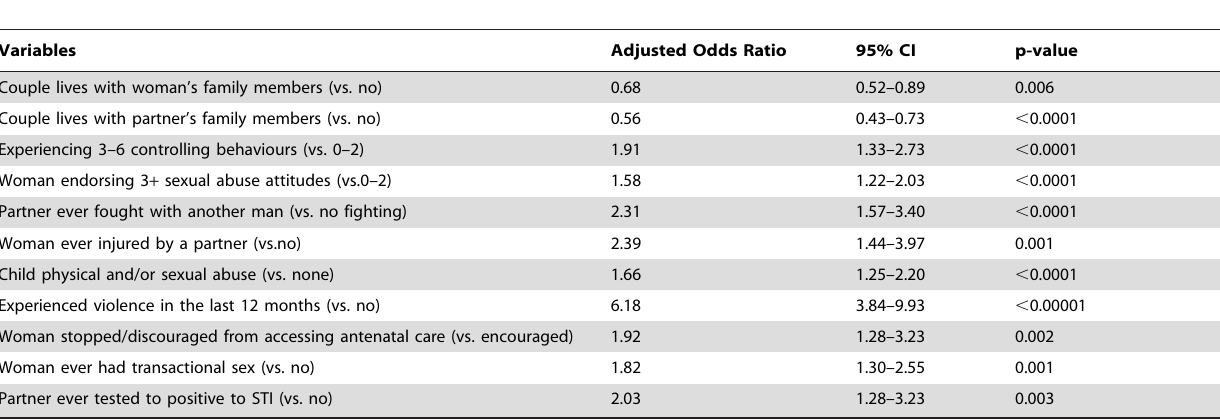
Table 3. Generalised ordered multiple regression analysis showing factors associated with medium to higher with none to lower IPV (physical, sexual and/or emotional) after disclosing HIV